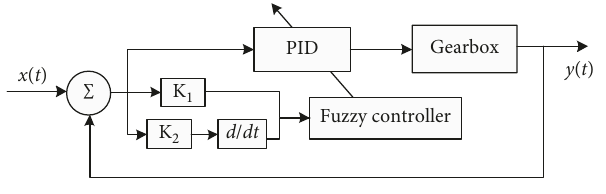
Figure 3: Flowchart of AFPID control algorithm.